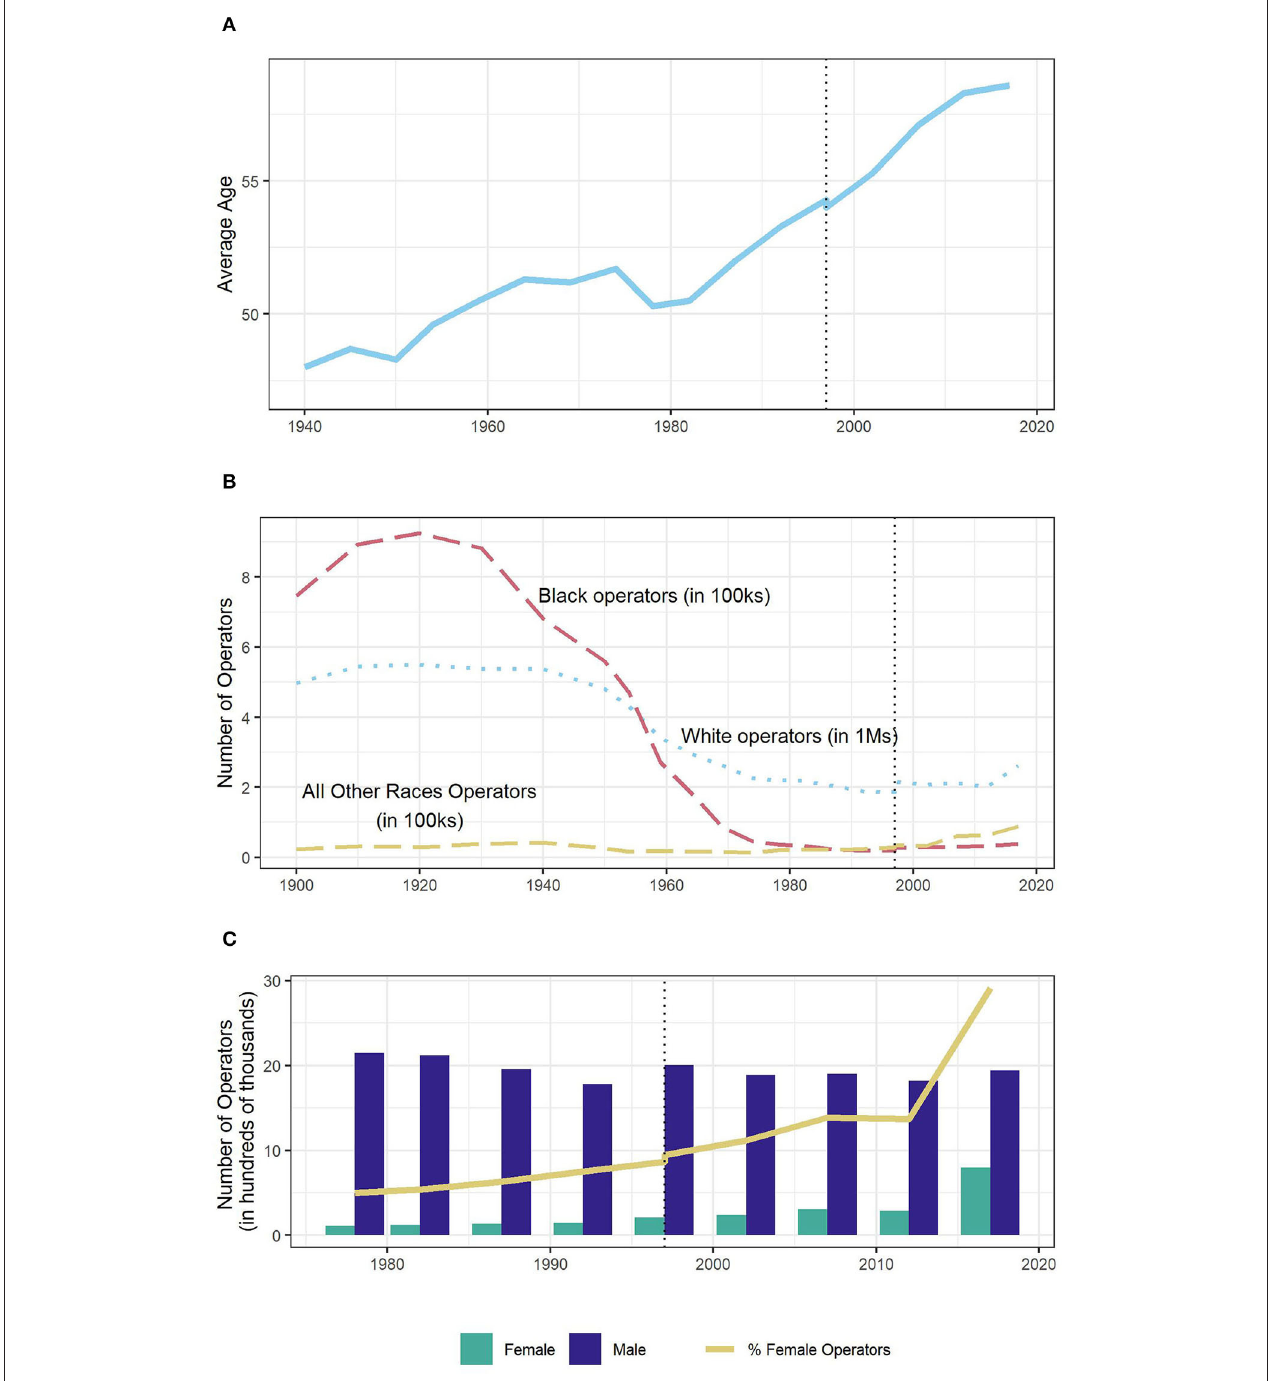
FIGURE 3 | (A) The average age of principal operators from 1940 to 2017. Note that the y axis begins at 47, not 0. (B) The number of US farms with principal operators identifying as Black (red), white (blue) and non-white and non-Black (yellow) from 1900 to 2017. For scale, farms operated by Black operators and members of all other races are shown in hundreds of thousands , while white operated farms are shown in millions . (C) Number of principal operators by reported gender (hundreds of thousands), overlayed with percent female principal operators. Note the 2017 CoA was the first year farms could report multiple principal operators. Note adjustments for under coverage in 1997 (unadjusted = 54.3, adjusted = 54.0). Finally, note the multiple x-axis scales representing the various, inconsistent timeframes for which agricultural data are available. Data: USDA ERS, compiled by R.